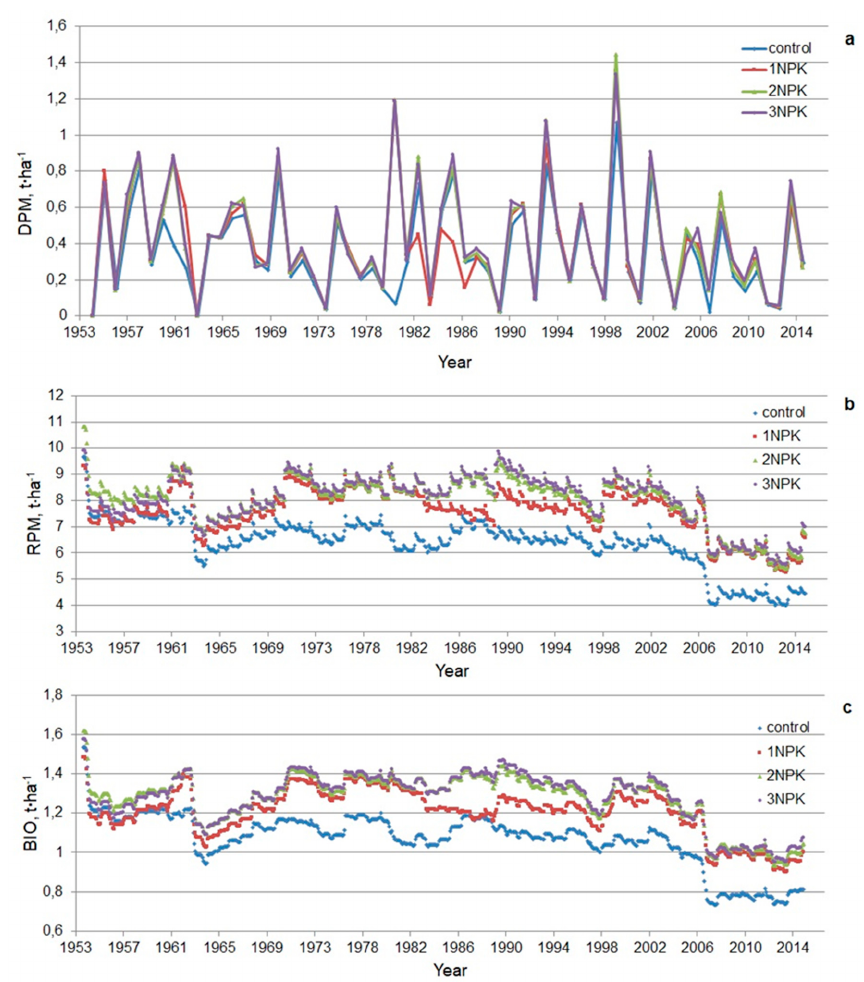
Figure 7. The dynamics of decomposable plant material (DPM) ( a ), recalcitrant plant material (RPM) ( b ) and microbial biomass (BIO) ( c ) pools calculated from the RothC model. The graph ( a ) uses annual model data for July, ( b , c ) use monthly model data .